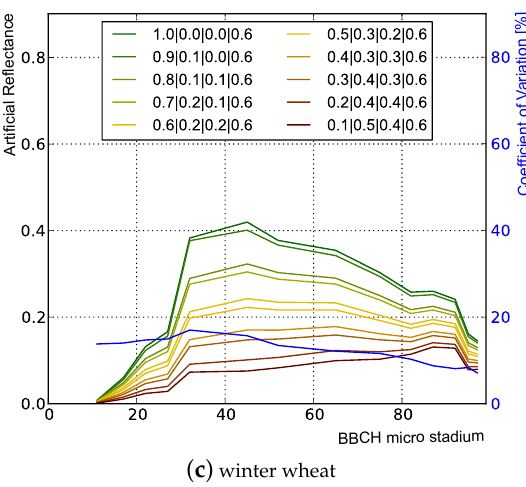
Figure 4. Influence of different artificial optical characteristics of plant parts on the canopy reflectance of ( a ) winter barley; ( b ) winter rye and ( c ) winter wheat during phenological growth stages (BBCH). The legend description gives the values for the artificial optical characteristics of: leaves and stems reflectance | leaves and stems transmittance | leaves and stems absorptance | ears reflectance. The blue line corresponds to the coefficient of variation of the plotted